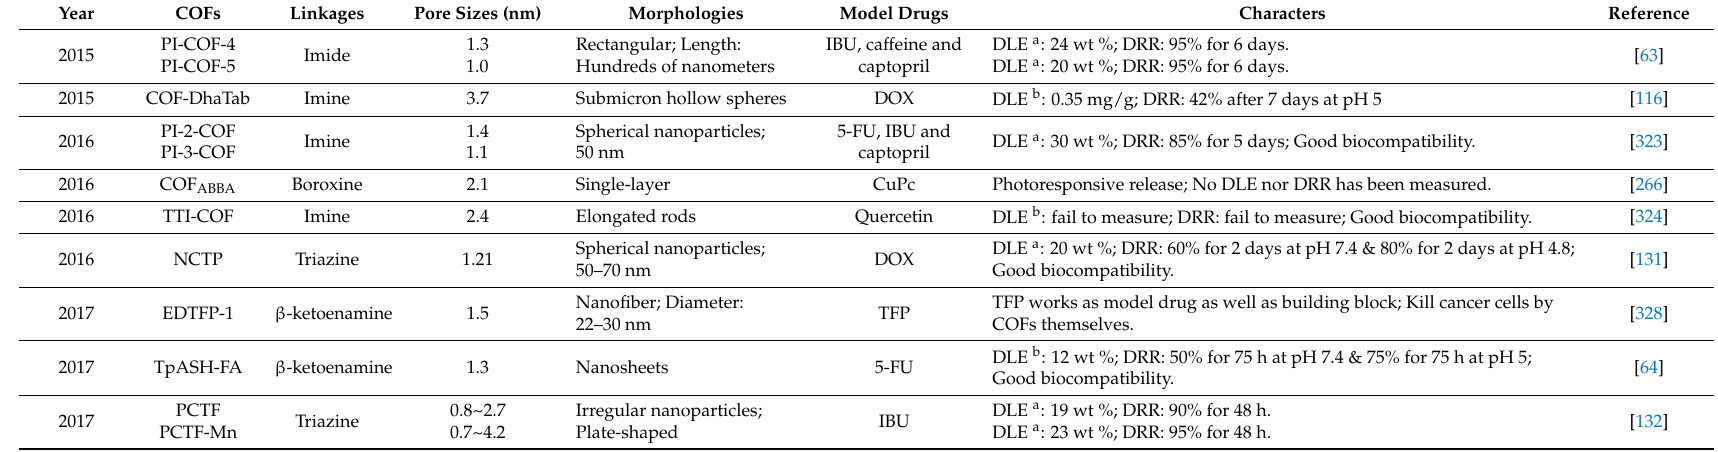
Table 3. Examples of COFs as drug